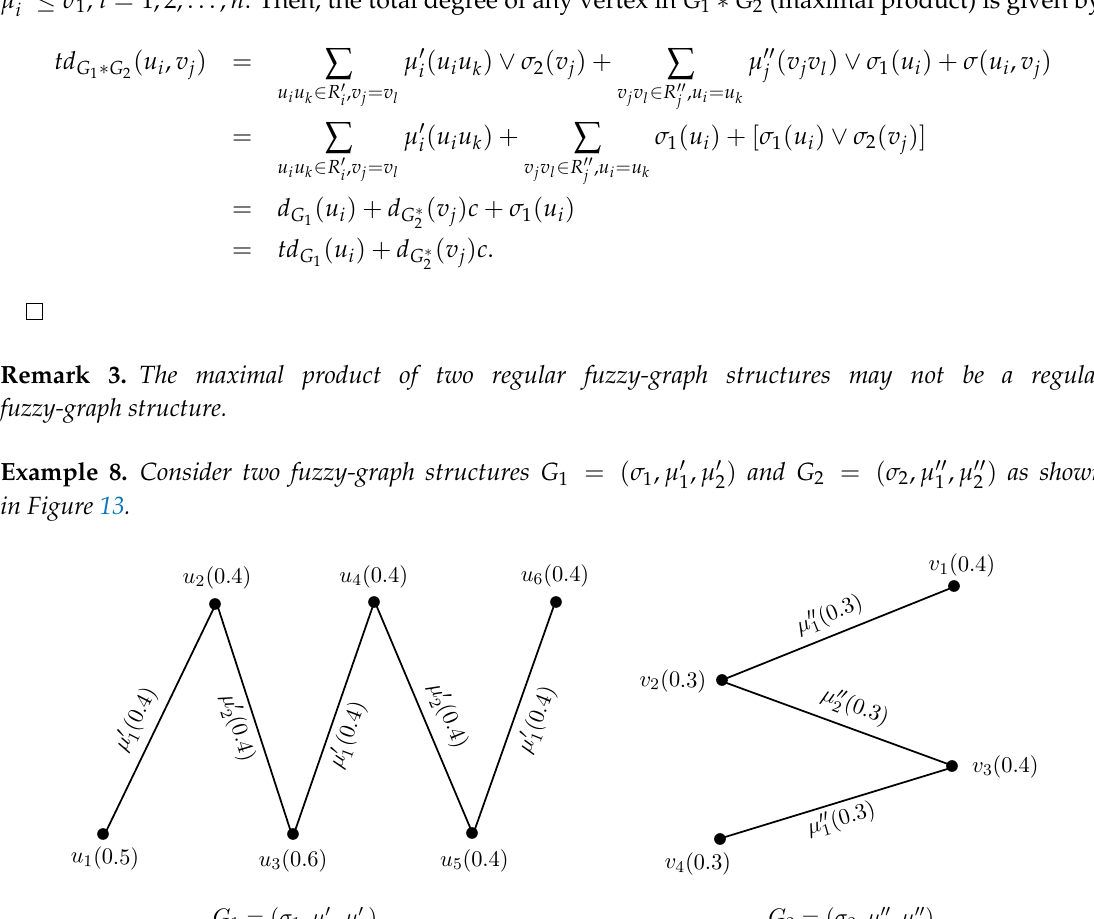
-regular and µ (cid:48)(cid:48) 1 -regular and µ ′′ 1